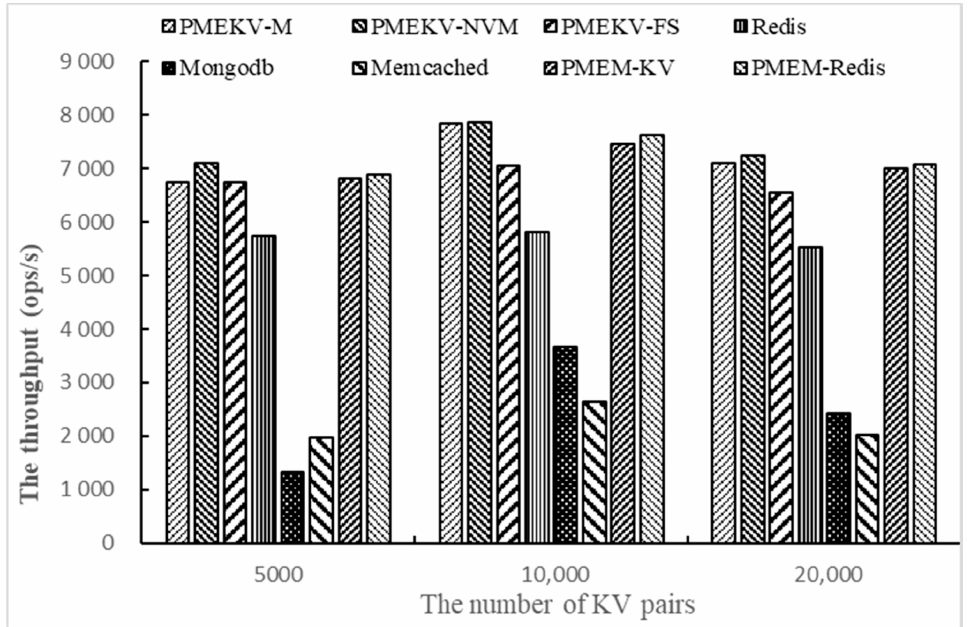
Figure 6. The throughput of changing the number of key–value pairs on Workloada.